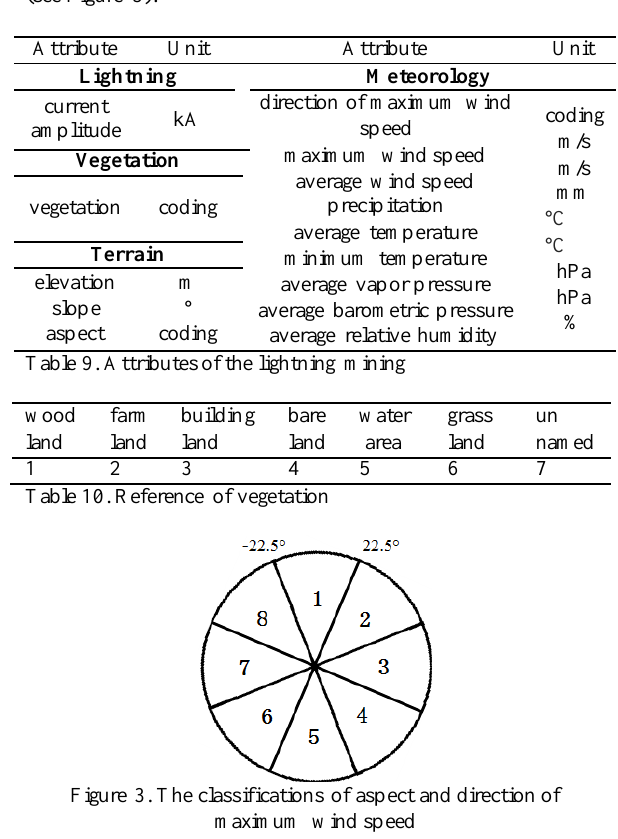
Figure 3. The classifications of aspect and direction of maximum wind